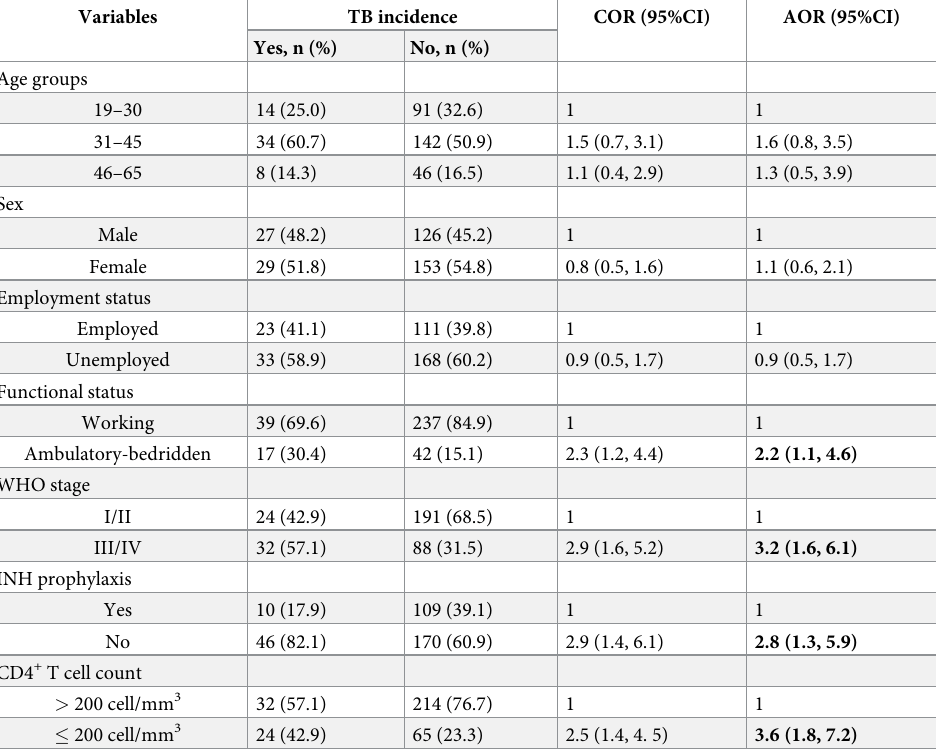
Table 3. Predictors of TB incidence in adults living with HIV in Gondar.